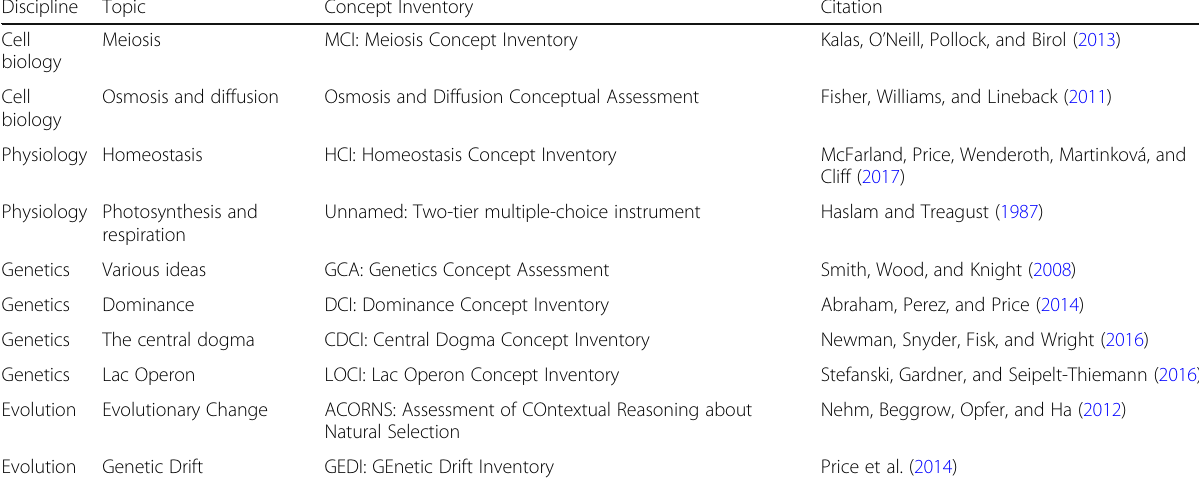
Table 2 Examples of Concept Inventories (CIs) targeting different biological disciplines and topics Discipline